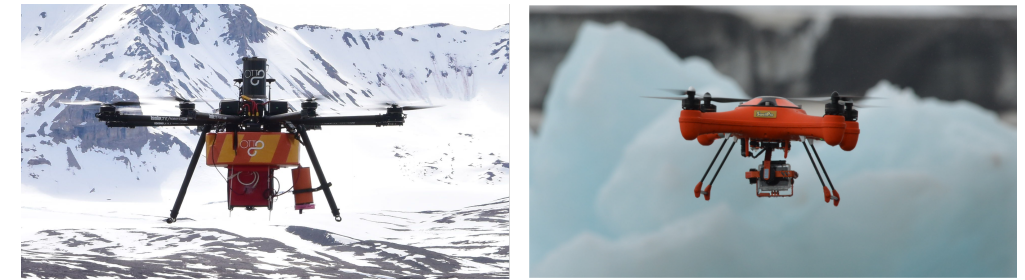
Figure 11. OTTO Unmanned Aerial Vehicle (UAV) and Splash